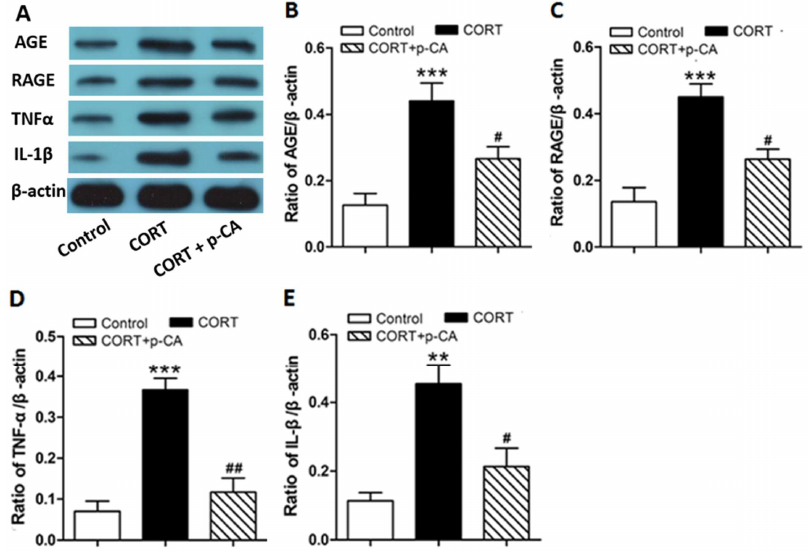
Figure 7. Effect of p-CA treatments on CORT-induced activation of AGE-RAGE signaling and re- lease of inflammatory cytokines in the hippocampus. Representative immunoblots of hippocampal AGE, RAGE, TNFα and IL-1β ( A ) and quantification of these proteins ( B – E ) in the hippocampus of control, CORT-treated and CORT + p-CA-treated mice ( n = 3). *** p < 0.001, ** p < 0.01, CORT group vs. control group; ## p < 0.01, # p < 0.05, CORT + p-CA group vs. CORT group. CORT, corticosterone; p-CA, p-coumaric acid.